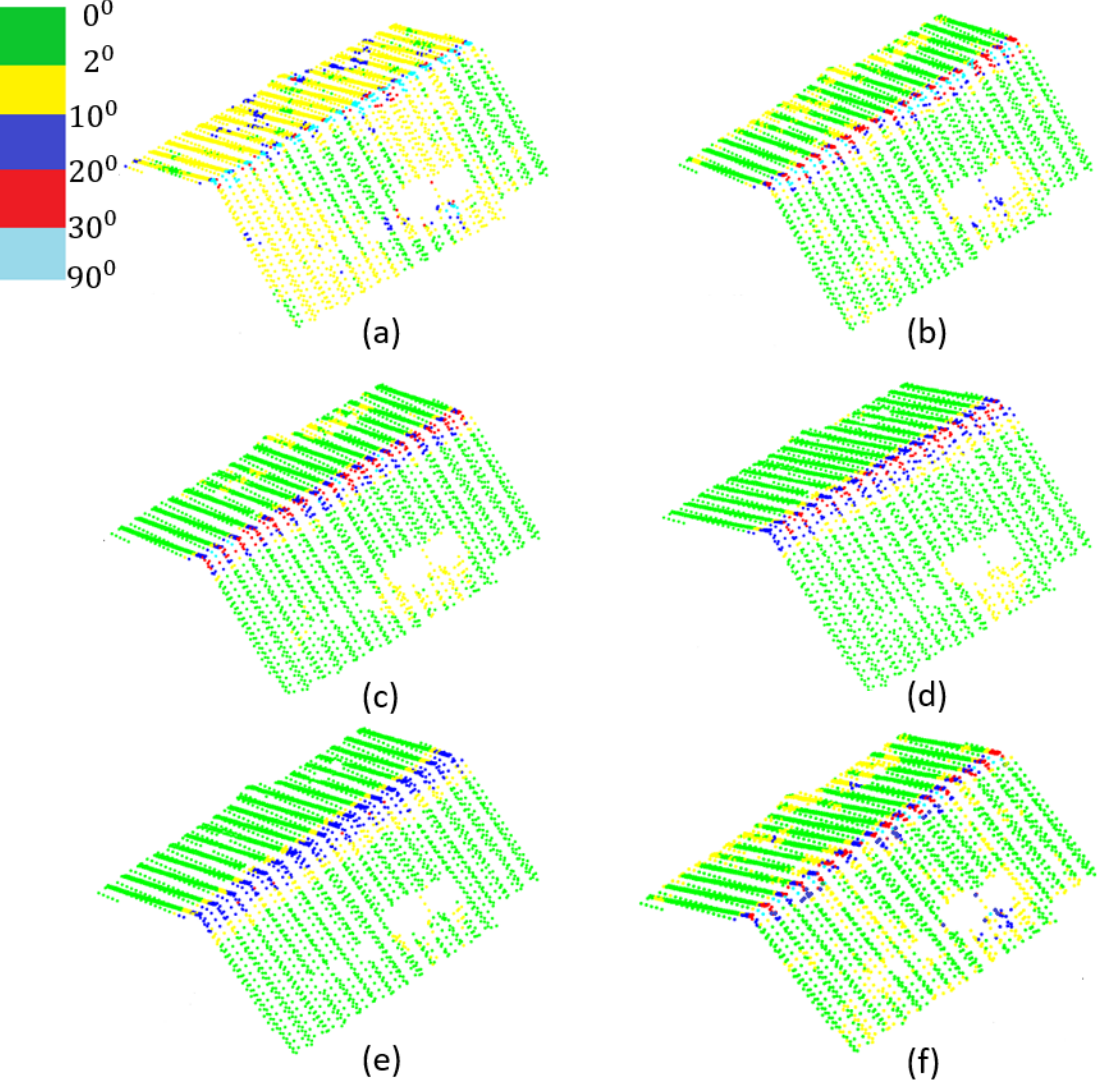
Figure 5. Calculated θ max for different neighbourhoods: ( a ) k = 9, ( b ) k = 20, ( c ) k = 30, ( d ) k = 45, ( e ) k = 60, and ( f ) the proposed neighbourhood. Table 1. Comparison of different fixed neighbourhoods with our proposed